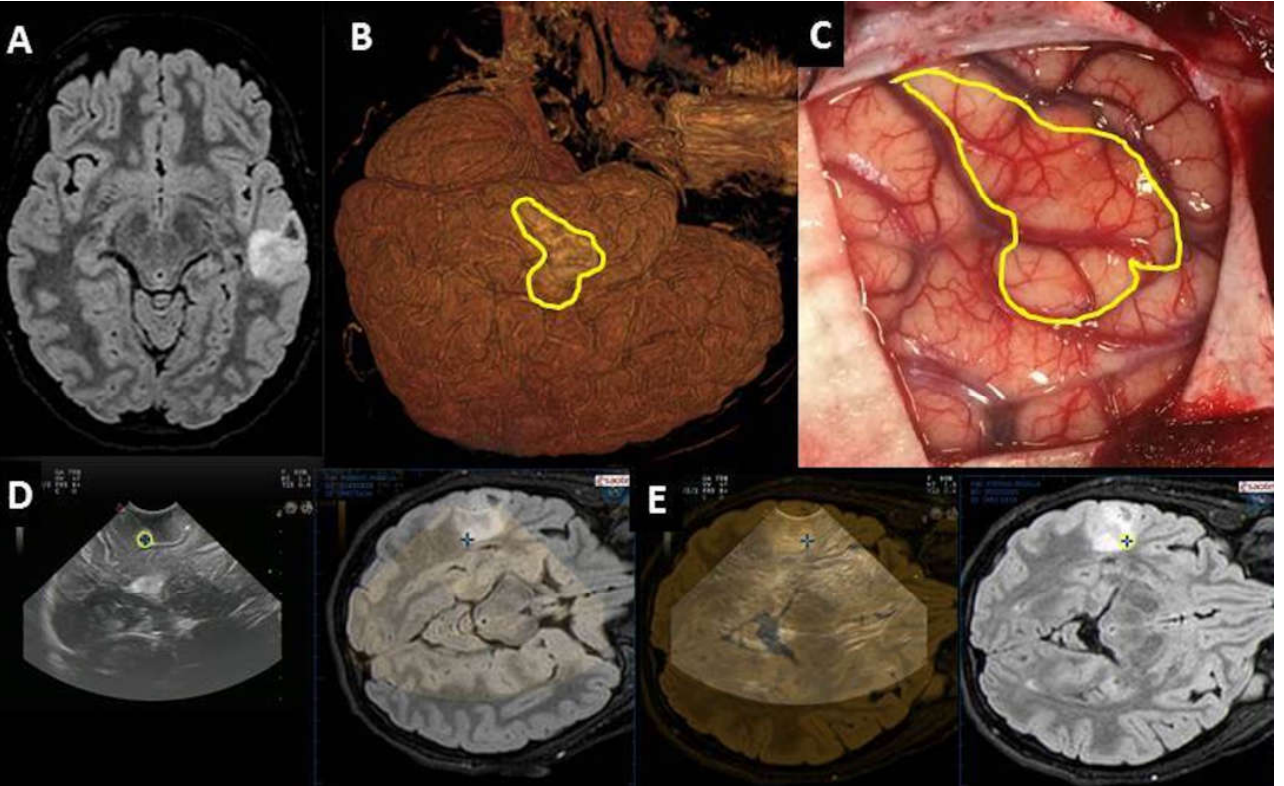
Figure 1. Left temporal DNT documented by MRI ( A ). The 3D reconstruction of brain surface ( B ) is consistent with intraoperative anatomy ( C ); intraoperatively, the tumor was not clearly distinguish- able from the normal brain parenchyma. Neuronavigated pre-IOUS showing the hypoechoic cortical tumor ( D ). The location of the tumor was confirmed by superimposing the preoperative MRI onto the IOUS image ( E ).